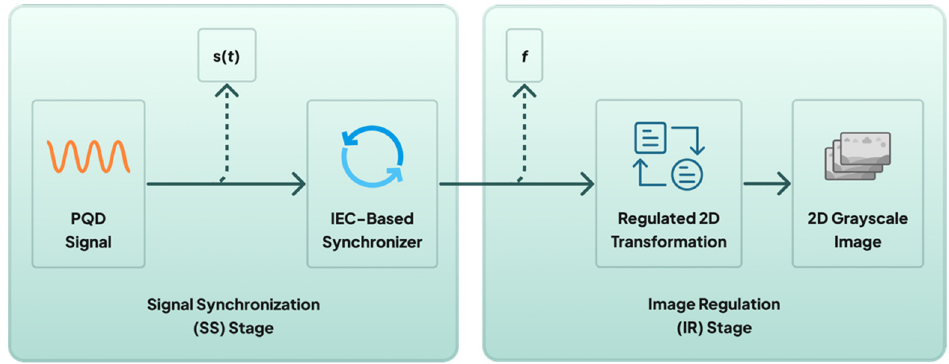
Figure 4. The stages of data preparation.